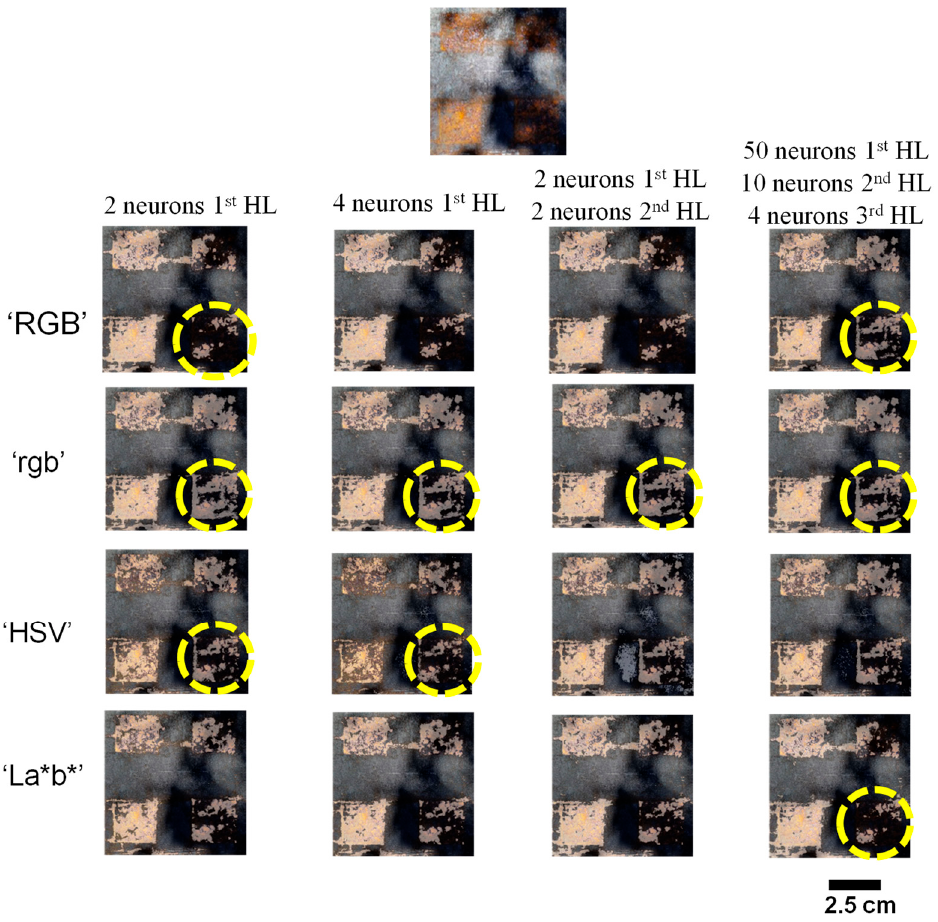
Figure 5. Prediction of corrosion in a test image (with shadow) using four different color spaces and four different ANN configurations. Markers for ‘RGB’–accuracy improved for three-layer MLP; Markers for ‘rgb’–accuracy remained almost same; Markers for ‘HSV’–accuracy is poor for 2 and 4 neurons MLP configuration; Markers for ‘CIE La*b*’–accuracy is poor for three-layer MLP configuration. Note HL–hidden layer.